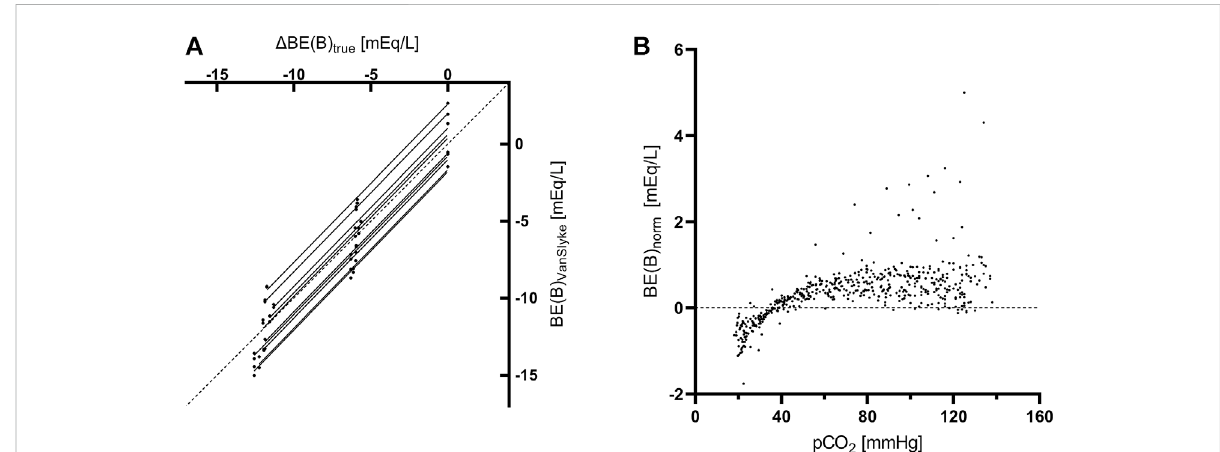
FIGURE 4 Analyses concerning the Base excess. (A) Linear regression of the true change of BE (B) determined from the amount and composition of the added stock solutions [ Δ BE(B) true ] vs. the value calculated using the Van Slyke equation [BE(B) VanSlyke ] at pCO 2 of 40 mmHg. Each aliquot is represented by 1 data point. The slope of the regression line was constrained as shared between volunteers and an individual regression line for aliquots of each volunteer is plotted. The dashed line is the line of identity. (B) Variance of normalized Base excess [BE(B) norm ] due to pCO 2 manipulations in whole blood. Each data point represents a single blood gas